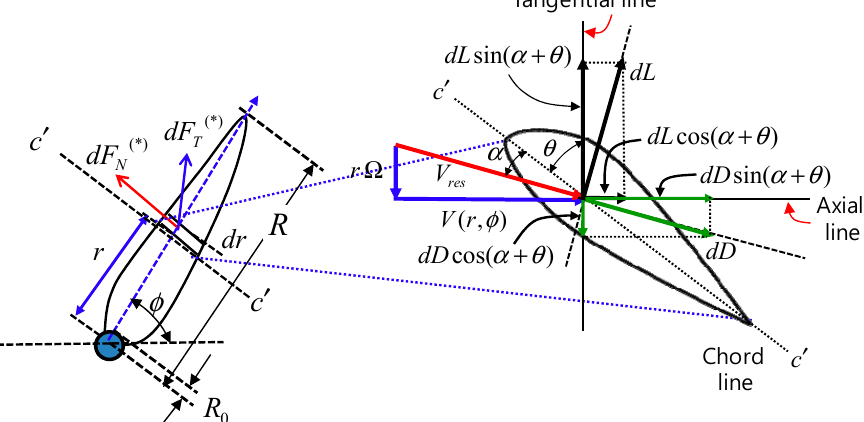
Figure 2. Blade element velocities and aerodynamic forces with respect to the blade local coordinate frame with the chord line(c’-c’) as a reference.